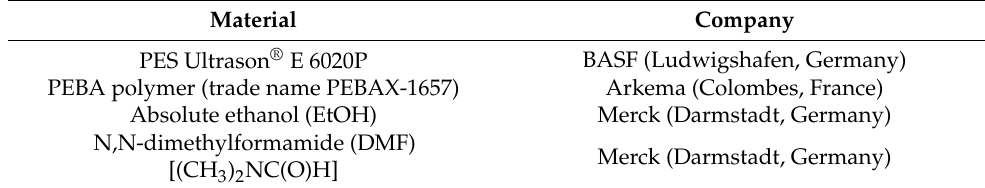
Table 2. Materials required for the synthesis of membranes and their properties.